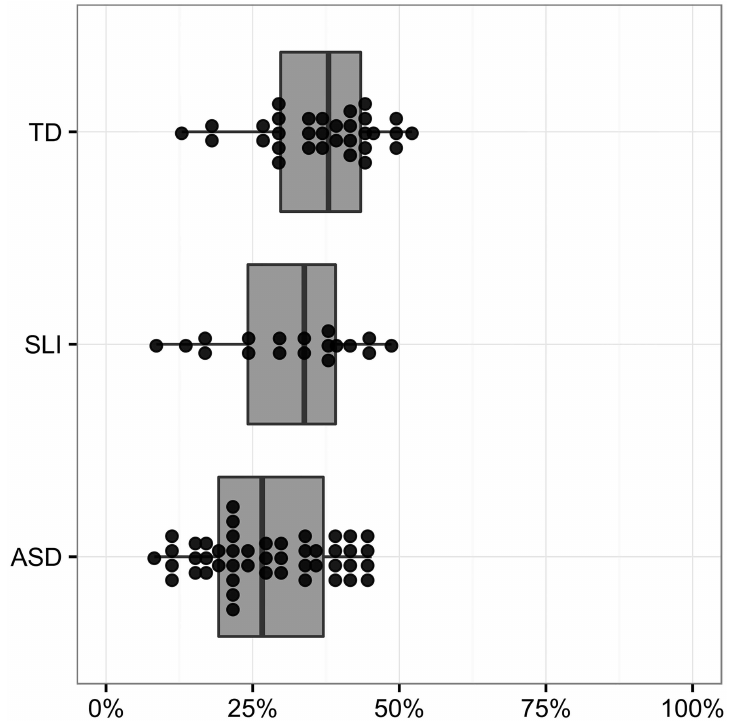
Fig 4. Percent of content mazeswhich are cued by a filler (versuscontent mazes which are not